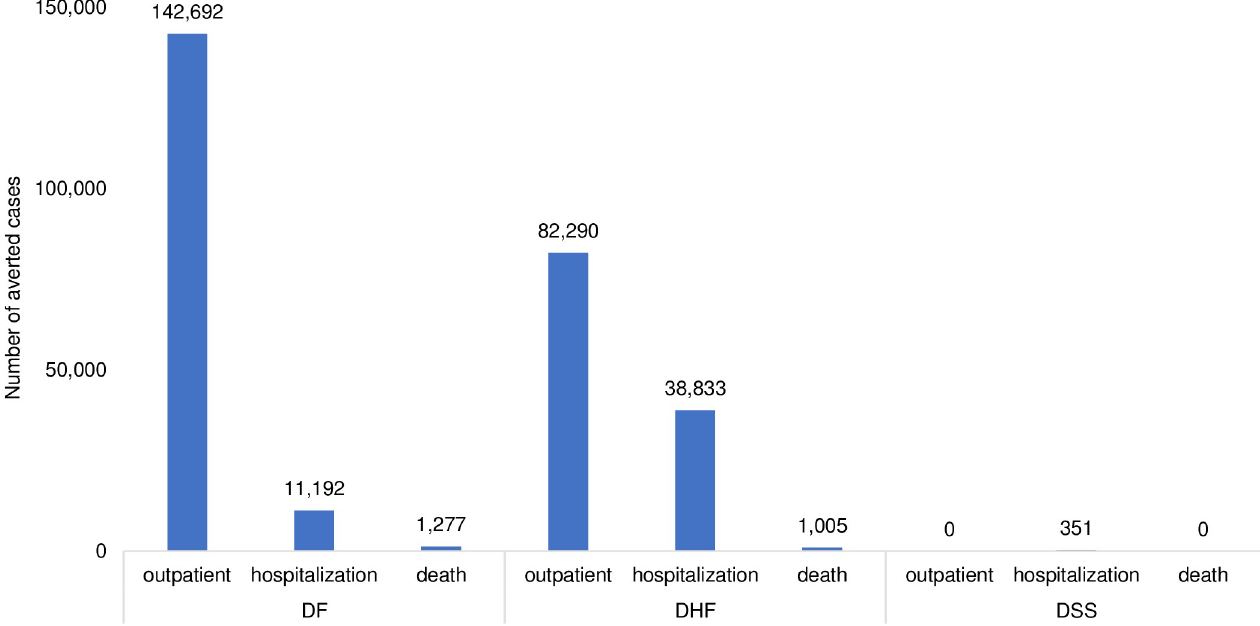
Fig 2. Number of averted cases due to vaccination and screening prior to vaccination (2020–2024).